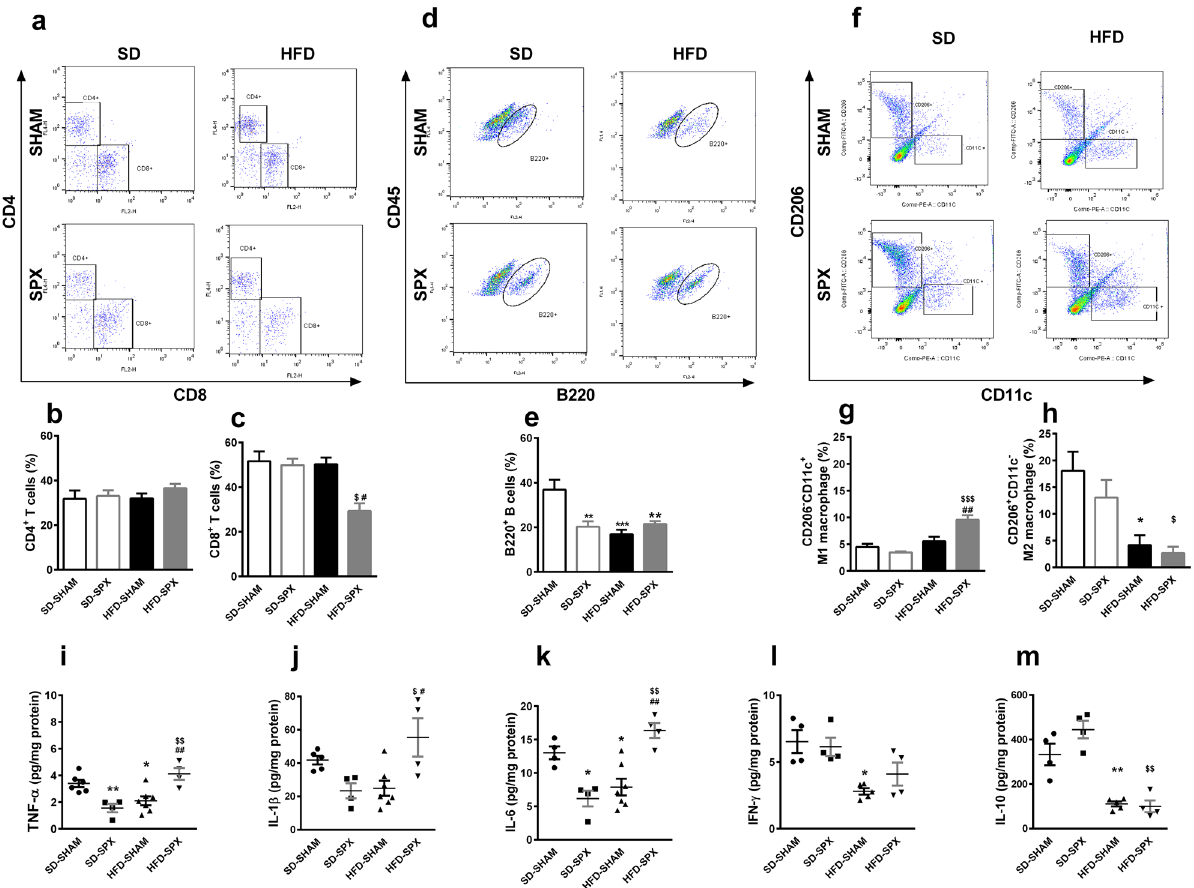
Figure 3. Splenectomy increased inflammatory markers in mesenteric PVAT (mPVAT) of mice fed a high- fat diet (HFD). ( a , d , f ) Representative dot plots of flow cytometry and populations of ( b ) CD4 + and ( c ) CD8 + T lymphocytes (percentage of CD3 + cells), ( e ) B220 + B lymphocytes (percentage of CD45 + cells) and ( g ) CD206 - CD11c + (M1) and ( h ) CD206 + CD11c − (M2) macrophages (percentage of F4/80 + cells) in the mPVAT of sham-operated (SHAM) or splenectomized (SPX) mice fed with standard diet (SD) or HFD. Results from two different experiments (n = 5 to 9 per group). ( i – m ) Cytokine levels in mPVAT of SD-SHAM, SD-SPX, HFD- SHAM and HFD-SPX mice. (n = 5 to 7 per group). Data were expressed as mean ± SEM. ANOVA: * P < 0.05, ** P < 0.01 and *** P < 0.001, SD-SPX and HFD-SHAM versus SD-SHAM; $ P < 0.05, $$ P < 0.01, $$$ P < 0.001